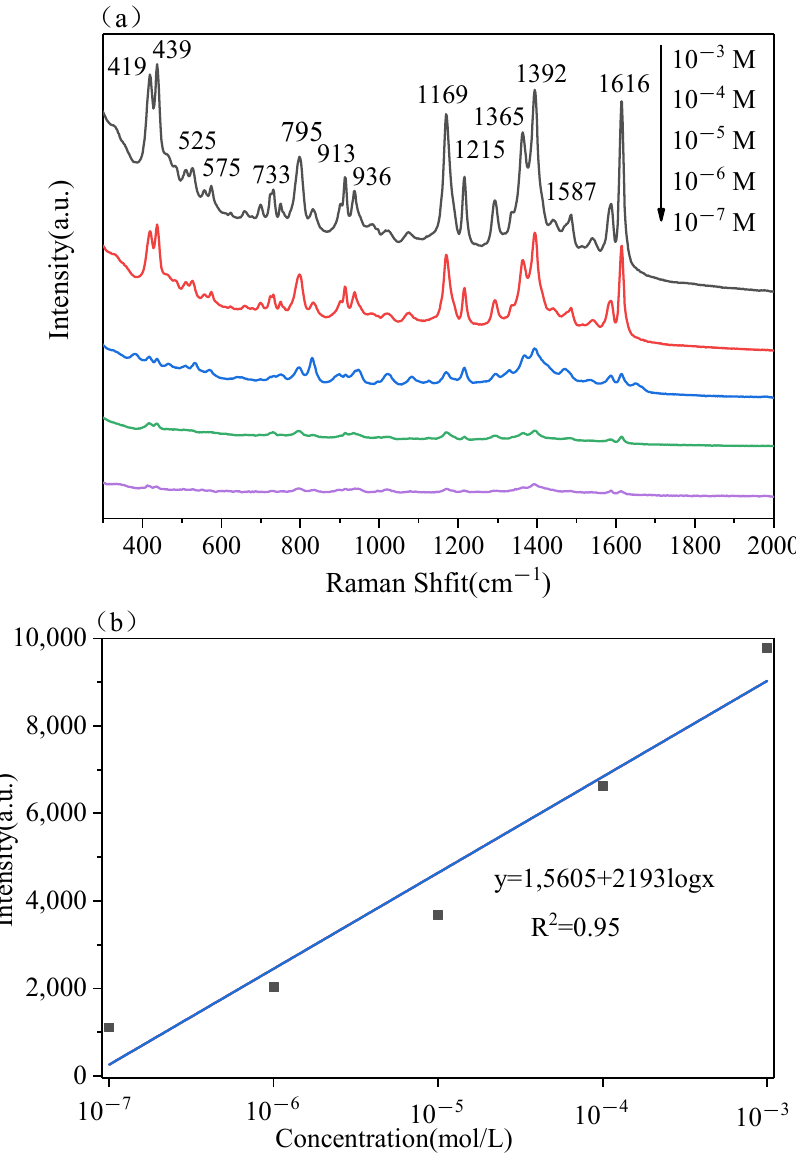
Figure 6. SERS spectra of MG with different concentrations from the LBL PS/Ag substrate ( a ), dose- response curves of the Raman peaks at 796 cm − 1 ( b ). Portable Raman spectrometer, laser λ = 785 nm, acquisition time: 2 s.